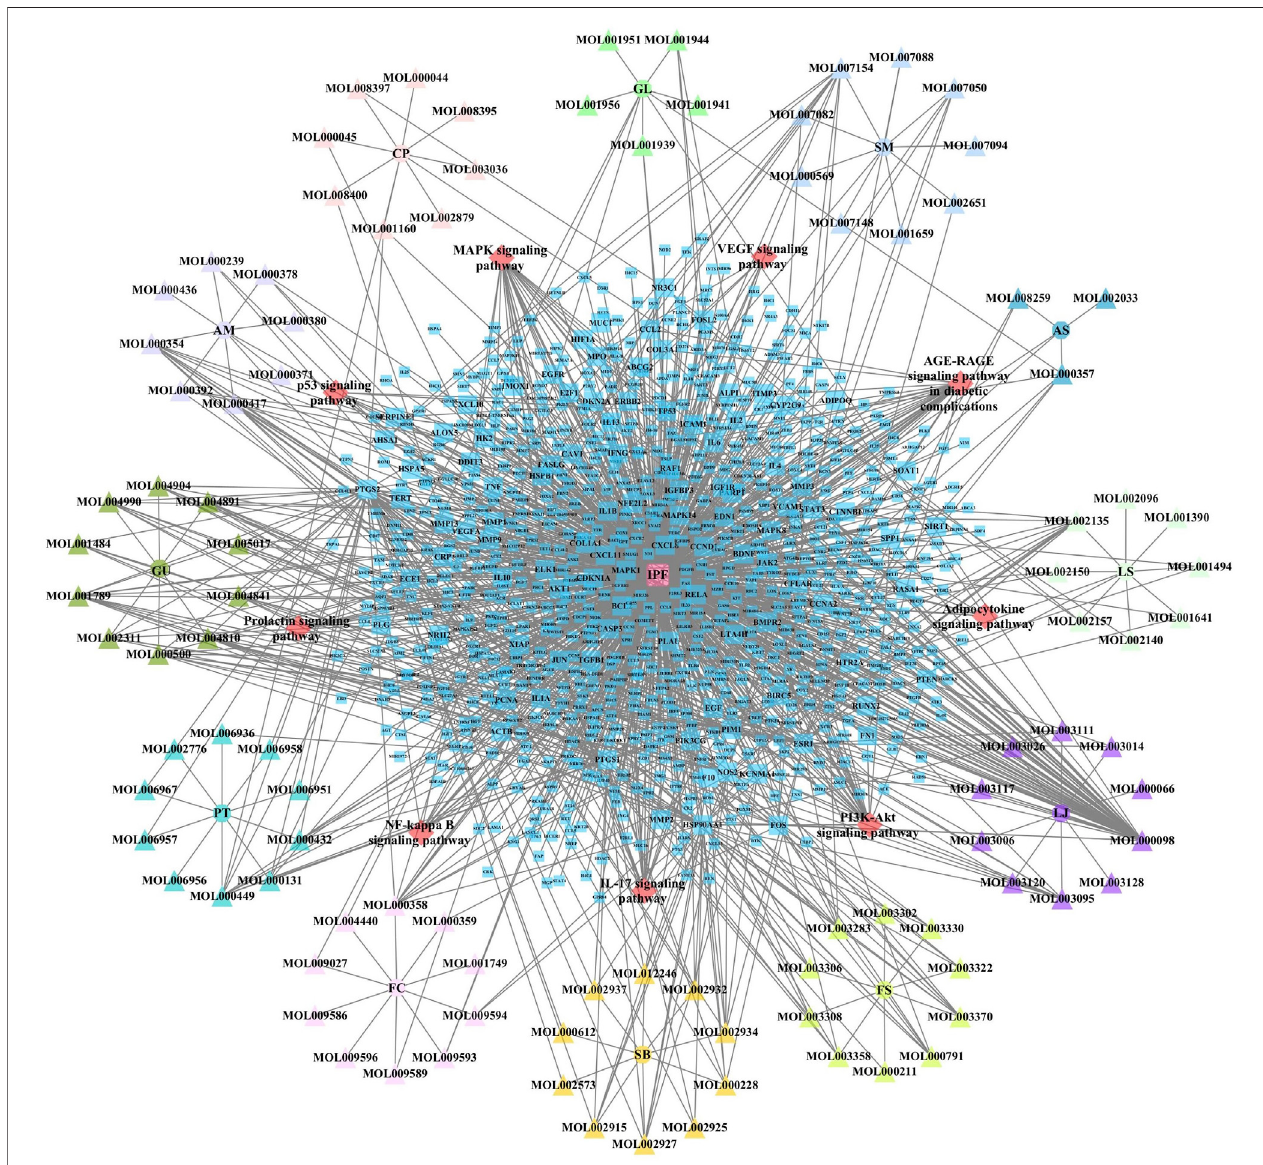
FIGURE 2 | The compound – target network of JBOL. Circles represent herbs, triangles represent compounds derived from herbs, and squares represent the predicted targets. The node size indicates the value of the degree.